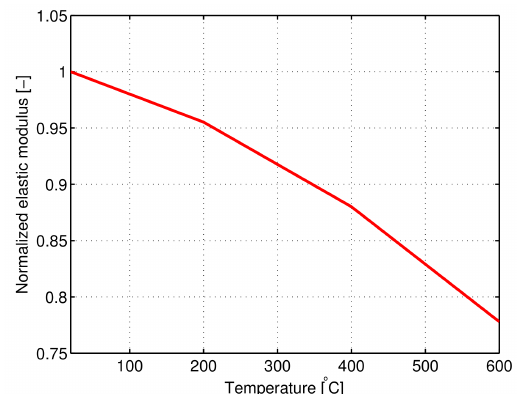
Figure 1. The temperature dependent Young’s mod- ulus.